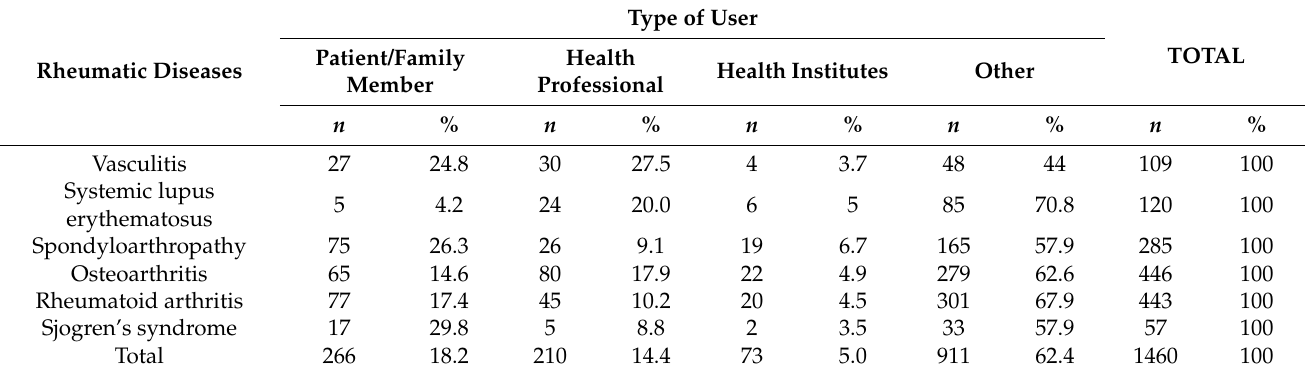
Table 4. Rheumatic diseases related tweets classified according to the type of Twitter user.